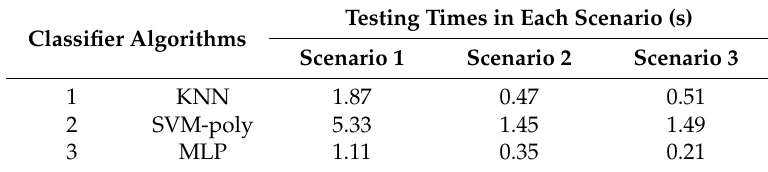
Table 3. Classification-based computational complexities.